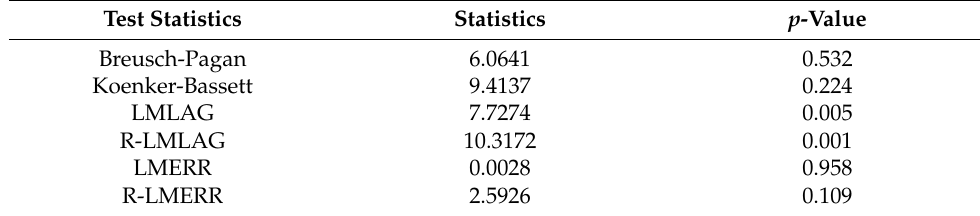
Table 5. Diagnostic test of OLS model estimation